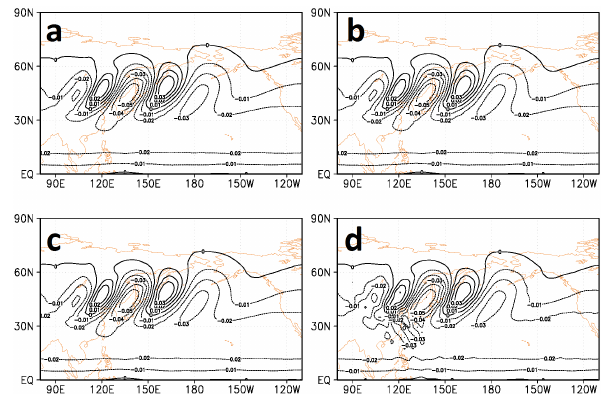
Figure 6. V-wind fields (ms -1 ) of the tangent linear model with different time increments at 5 hour later. Time step size ∆ t is a) 150, b) 300, c) 450, d) 600 second.